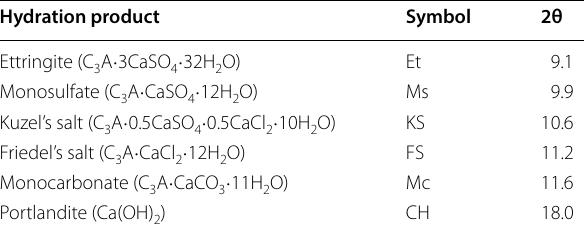
Fig. 3 Relation between admixture content and compressive